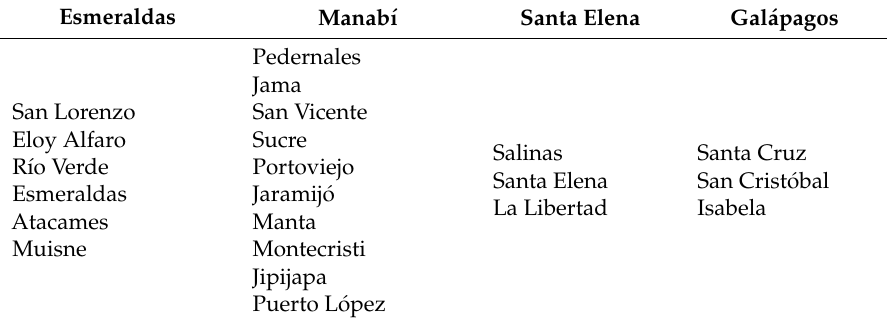
Table 1. Investigated cantons in the continental Ecuador and Galapagos Islands. The names of the provinces are in